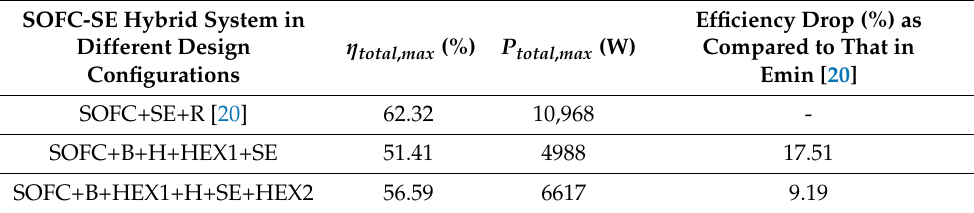
Table 3. Maximum system efficiency and power generated when system operated at 1173